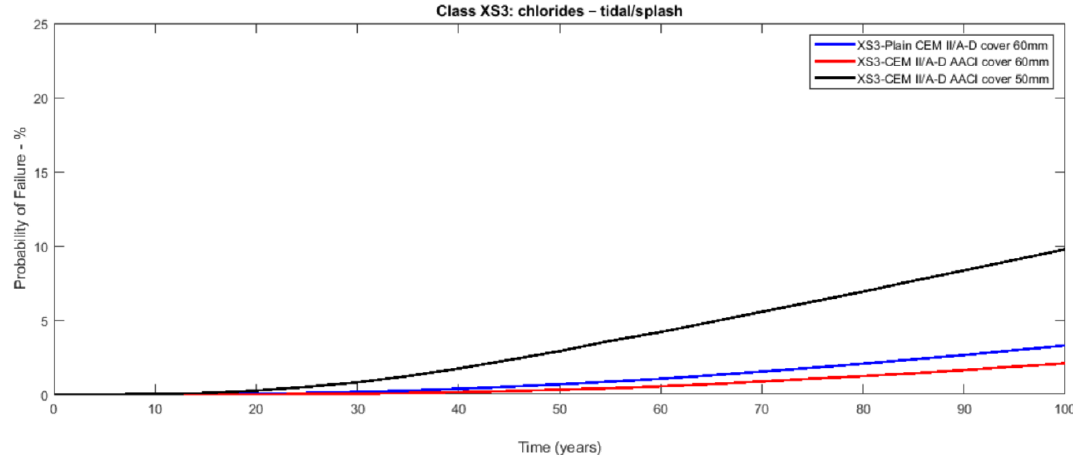
Figure 6. Probabilistic service life results of CEM III/A concrete—exposure class XS3 (tidal/splash)—without and with bioproduct for a cover of 60 and 50 mm.